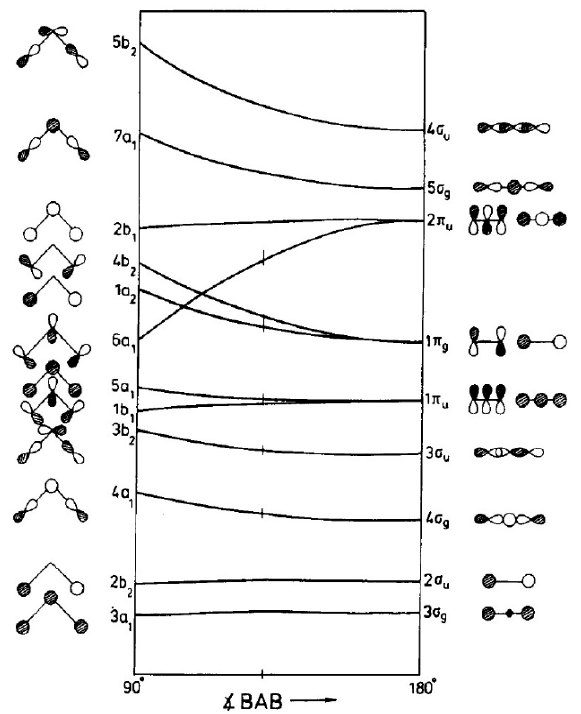
Figure 1. Walsh diagram of CO 2 orbital energies in linear and bent geometries. Reprinted with permission from [1]. Copyright 1996 Elsevier.